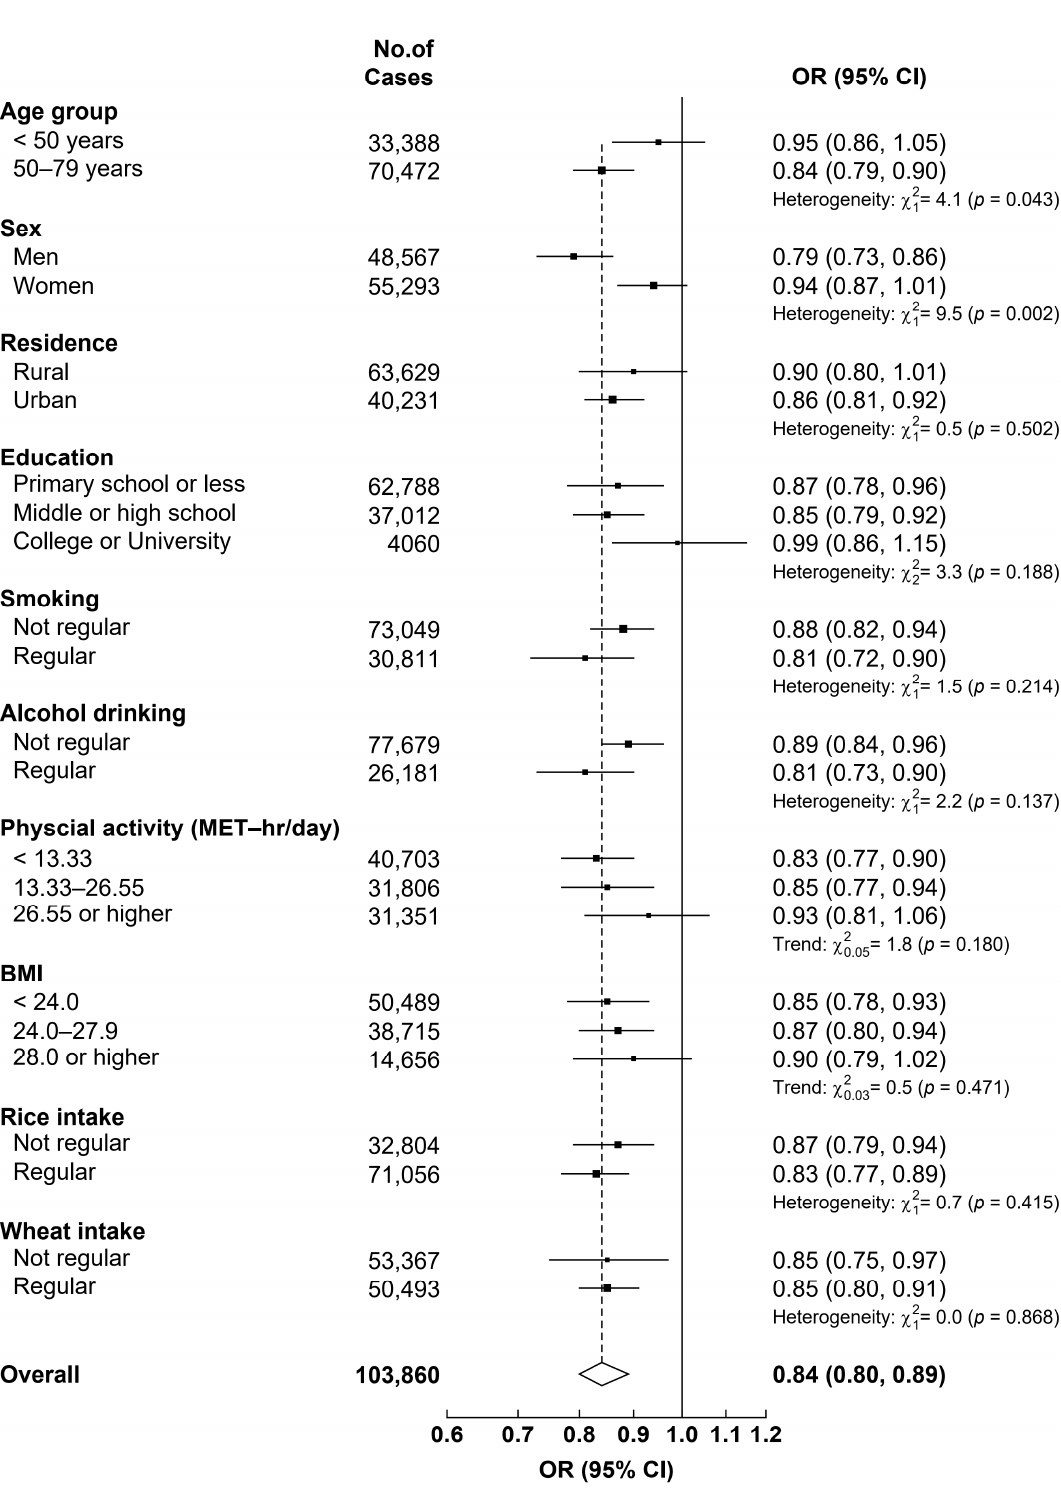
Figure 2. Adjusted odds ratios (ORs) of undiagnosed hypertension in those who have regular coarse grain intake (at least 4 days / week) vs. those who did not have by selected characteristics.